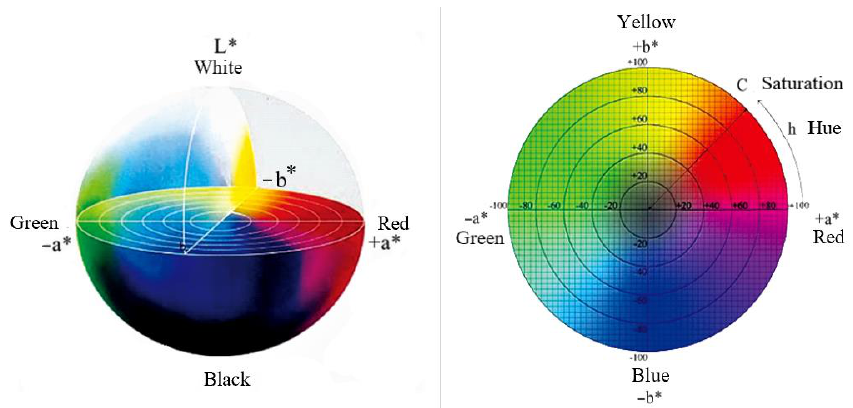
Figure 6. CIE Lab colour